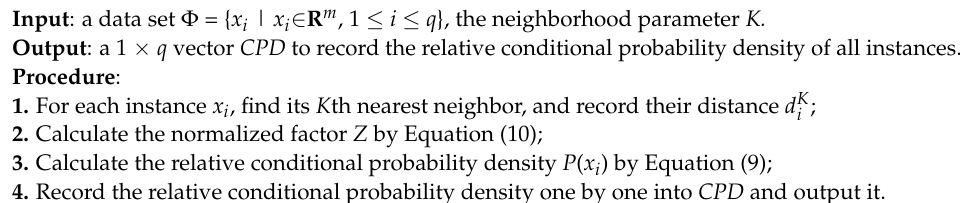
Algorithm 1. KNN-PDE-alike